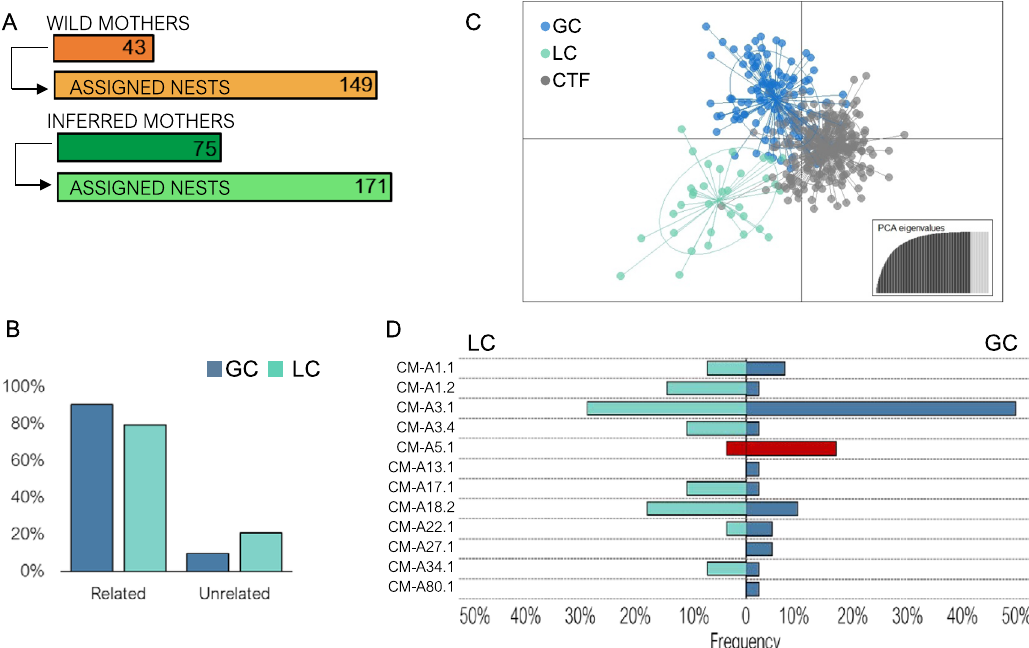
Fig. 3 Population differentiation from the captive population. A Number of wild (orange) and inferred (green) mothers and number of nests assigned respectively according to parentage analysis using COLONY. B Percentage of nests in Grand Cayman (GC) and Little Cayman (LC) found to be related or unrelated to the Cayman Turtle Farm (CTF) breeding stock as shown by Coancestry and ML-Relate. Both new populations show a high degree of relatedness to the CTF captive population. C Discriminant Analysis of Principal Components ( n = 406 individuals) of GC and LC nests, and CTF breeders, showing the dispersion of the genotypes of the new populations due to a founder effect; the inset shows Principal Component Analysis eigenvalues, retained axes are in black. D Frequency of D-Loop haplotypes found in GC and LC nests indicating variations in the frequencies, probably caused by the founder effect. Blue shaded haplotypes belong to the Northern lineage and the red haplotype to the Southern lineage 29